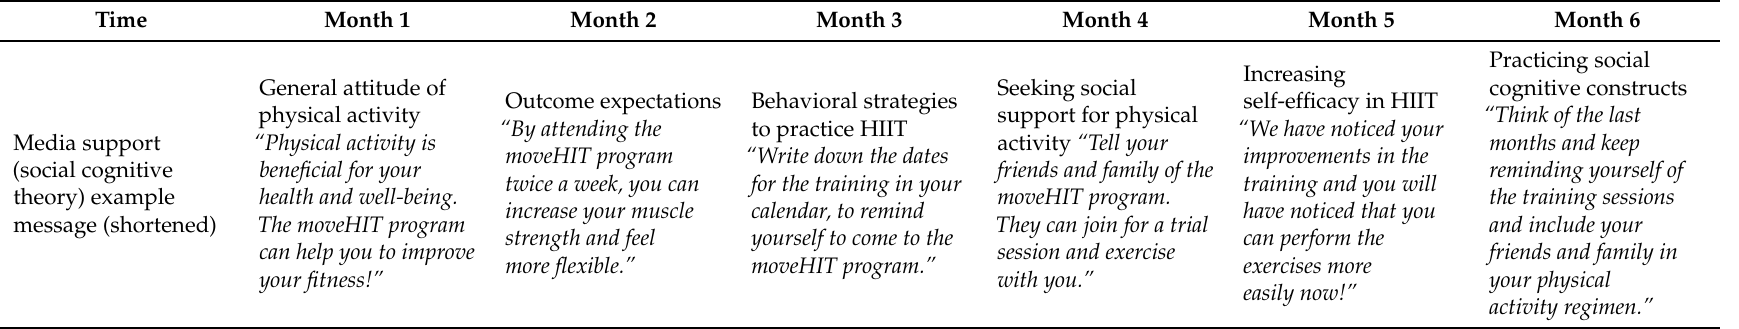
Table 1. Text message content over the course of the